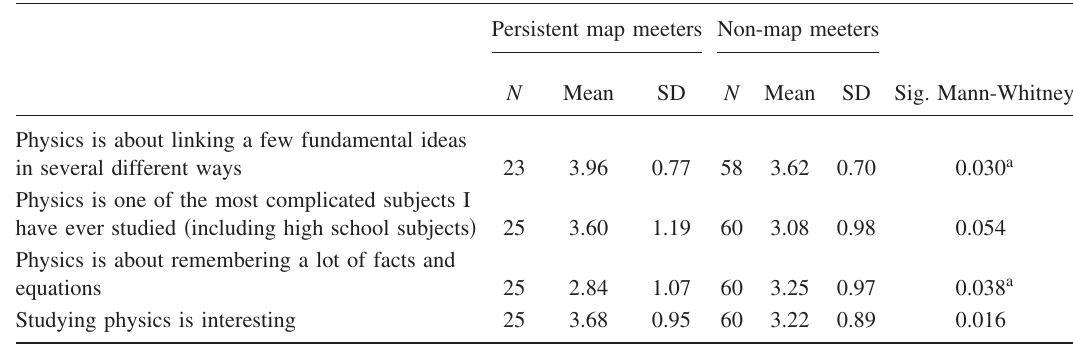
TABLE II. Student response to general questions about